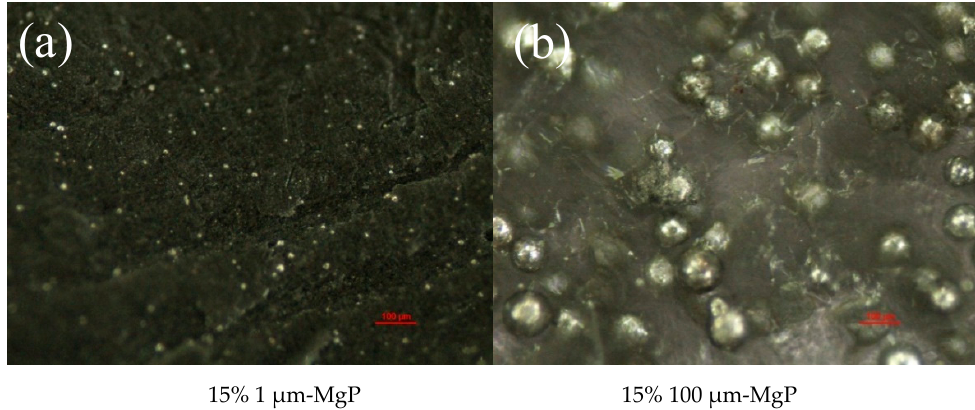
Figure 9. Optical microscope images of small ( a ) and large ( b ) magnesium particles/paraffin composite fuels.